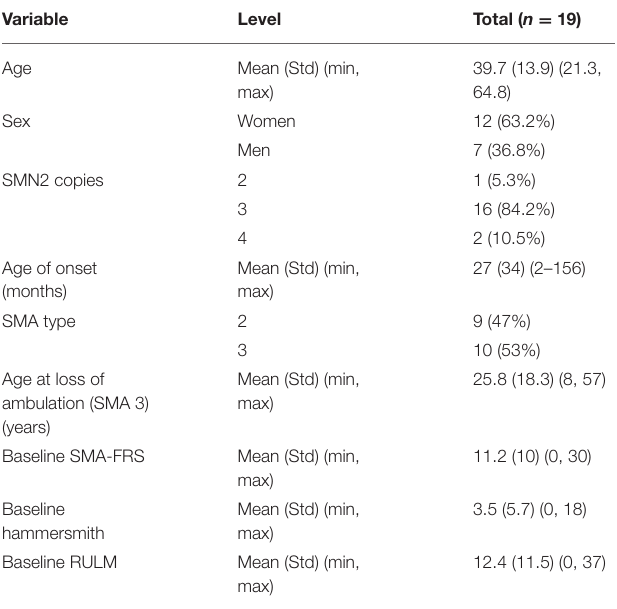
TABLE 1 | Demographics, genotype and phenotype characteristics, and baseline functional assessment.